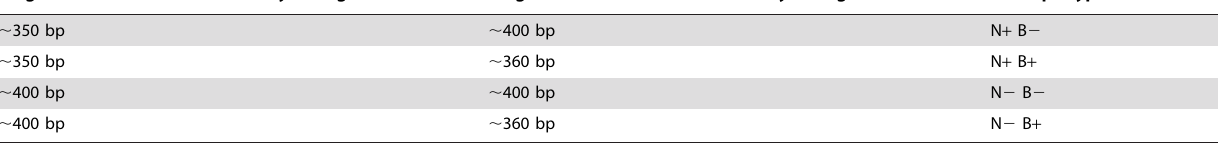
Table 1. Key to the ‘NB system’ routinely used for gypsy moth